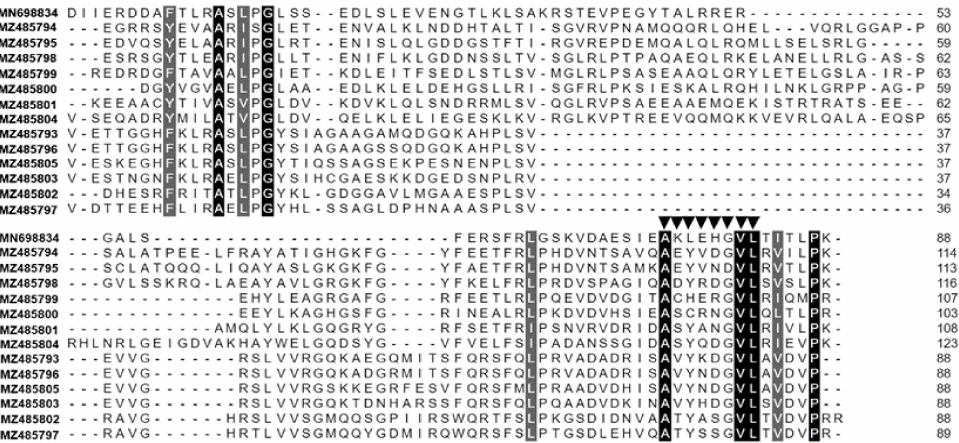
Figure 1. Alignment and comparison of the ACD domains of 14 dinoflagellate sHsps. GenBank accession numbers of these sequences are noted on the left. Similar and identical amino acid residues are gray and black shaded, respectively. The typical A-X-X-X-N-G-V-L motif inside the ACD region are marked by triangles above alignment. Deletions are shown by